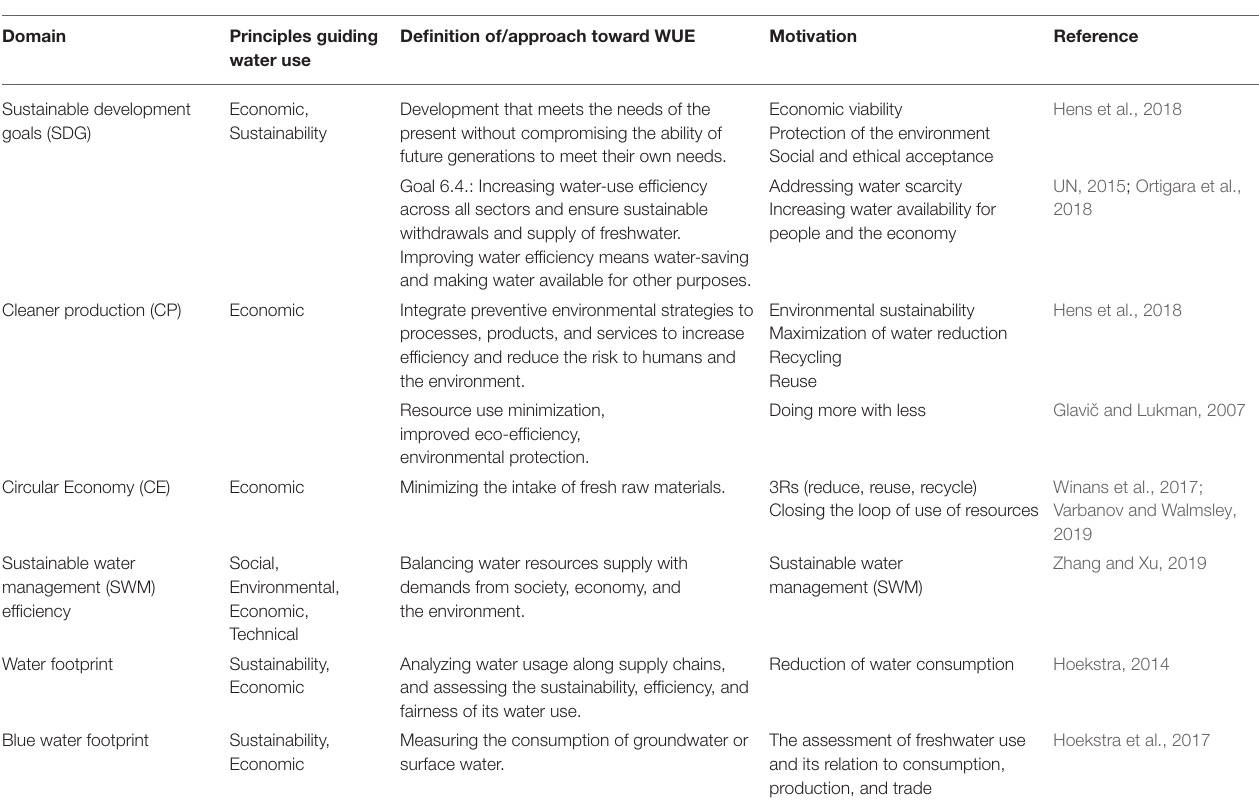
TABLE 2 | Approaches toward improving WUE.